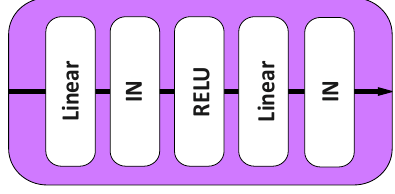
Figure 3. IFFM architecture.